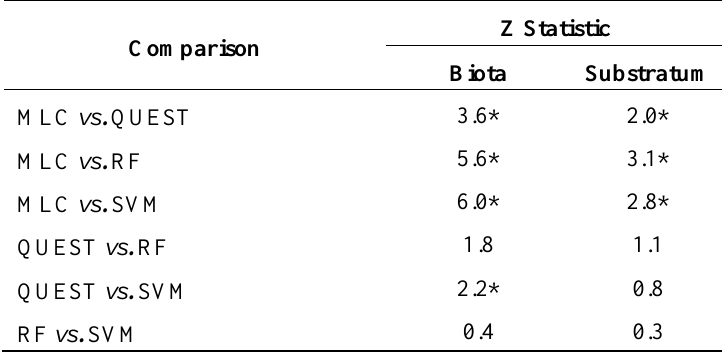
Table 2. Z values from pairwise comparison of error matrices between different classifiers. MLC = Maximum Likelihood Classifier, QUEST = QUEST decision tree, RF = Random Forest decision tree, SVM = Support Vector Machine.